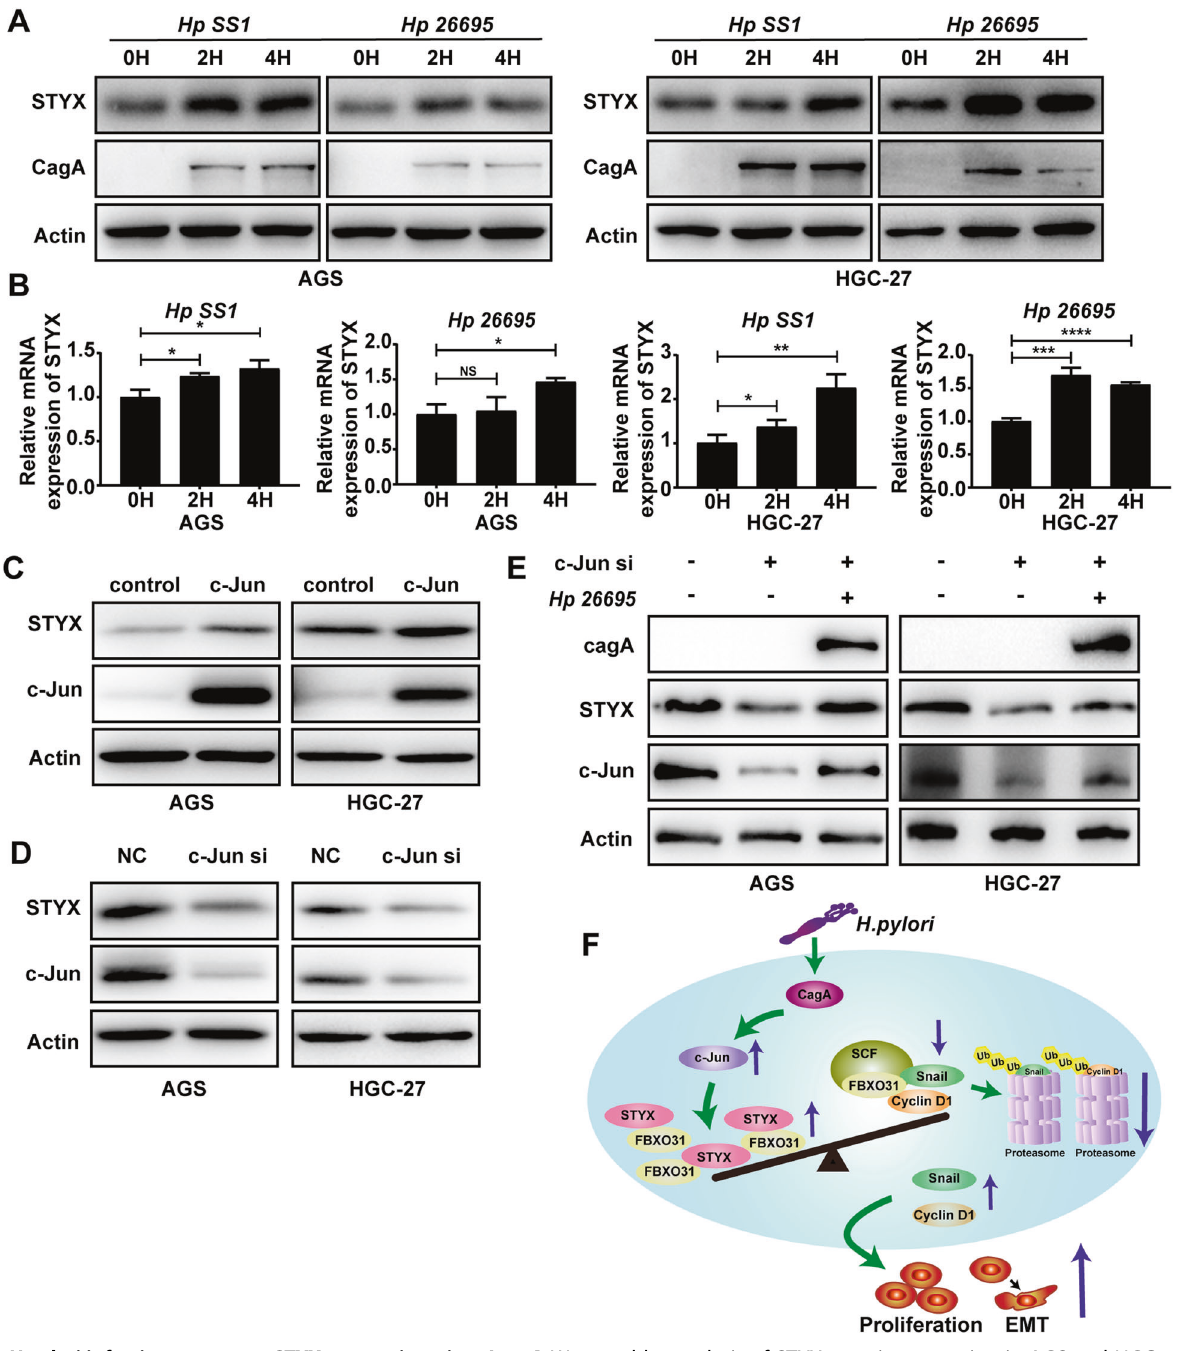
Fig. 8 H.pylori infection promotes STYX expression via c-Jun. A Western blot analysis of STYX protein expression in AGS and HGC-27 cells infected with H.pylori (SS1 or 26695) at different time points. B qRT-qPCR analysis of STYX mRNA expression in GC cells infected with H. pylori at different time points. C Western blot was used to detect STYX transfected with c-Jun expression vector. D Western blot was used to detect STYX transfected with c-Jun siRNA. E Western blot was used to detect STYX in GC cells co-transfected with c-Jun siRNA and H.pylori (26695). F Working model for STYX promoting carcinogenesis and metastasis of